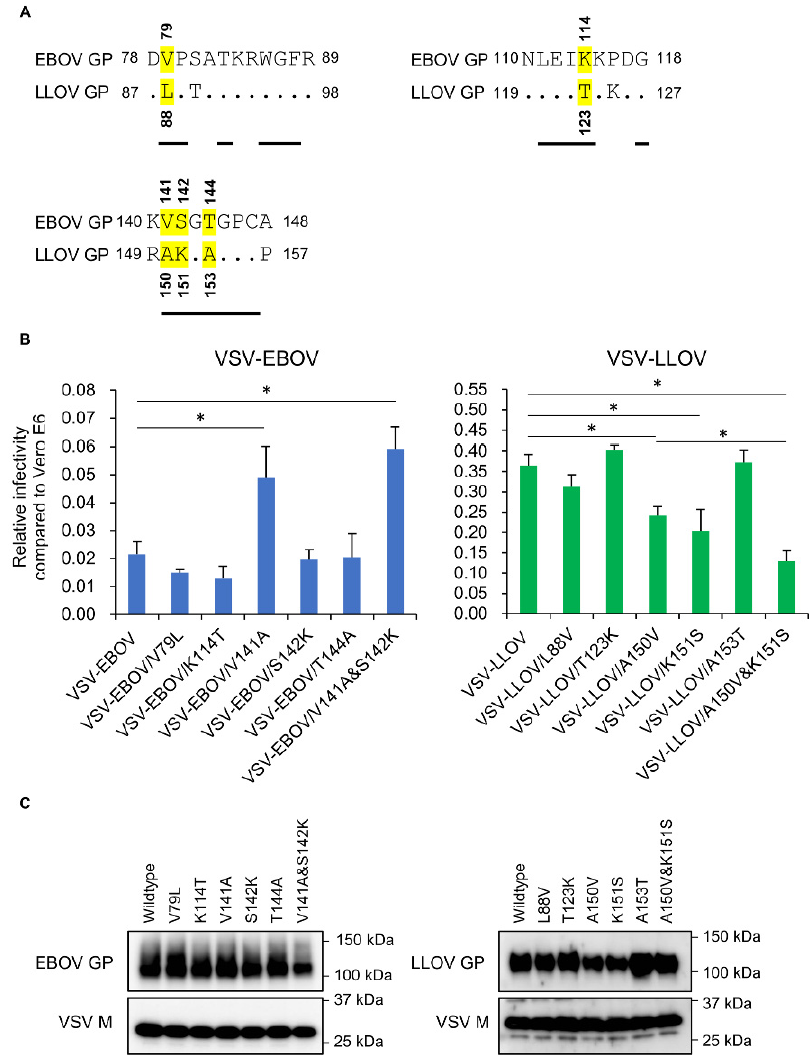
Figure 4. Amino acid differences in the receptor binding domain (RBD) between EBOV and LLOV GPs and effects of amino acid substitutions on the infectivities of pseudotyped VSVs in SuBK12-08 cells. ( A ) The deduced amino acid sequences of EBOV and LLOV GPs are aligned. The amino acid residues predicted to interact directly with the loop structures of NPC1-C, are underlined. The amino acid residues at positions 79, 114, 141, 142, and, 144 (EBOV numbering), which are assumed to interact with loop 1 and loop 2 of human NPC1-C, are highlighted in yellow. ( B ) Vero E6 and SuBK12-08 cells were infected with VSVs pseudotyped with EBOV, LLOV and their mutant GPs. Relative infectivity compared to Vero E6 cells was determined as described in Section 2. Each experiment was conducted three times, and averages and standard deviations are shown. For multiple comparisons of viral infectivities among pseudotyped VSVs, one-way analysis of variance was performed, followed by Dunnett’s test. For comparison of the infectivities of pseudotyped VSVs with single and double mutations, the Student t -test was performed. Significant di ff erences are shown with asterisks (* p < 0.05). ( C ) The amounts of GPs incorporated into VSV particles. Each virus was subjected to SDS-PAGE followed by Western